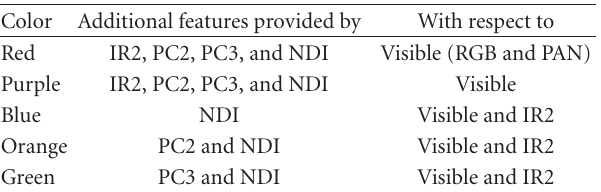
Table 1: Additional features provided by IR2 with respect to visible, and by PCA and NDI with respect to visible and